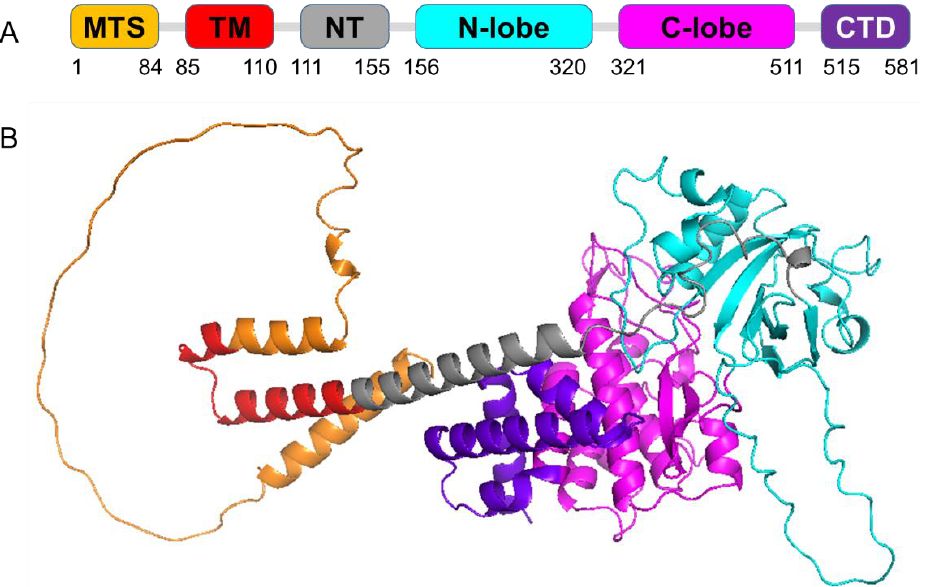
Figure 2. Three-dimensional (3D) predicted model of full-length human Pink1 (581 amino acid residues) (AlphaFold predicted model: Q9BXM7). Pink1 domain structure ( A ) and cartoon representation ( B ) are shown in colors that correspond to the respective domain colors. The domains are colored as follows: mitochondrial targeting sequence (MTS, orange), transmembrane region (TM, red), N-terminal regulatory region (NT, gray), N-lobe of the kinase domain (cyan), C-lobe of the kinase domain (magenta) and the C-terminal domain (CTD, purple). PyMol (Schrodinger LLC) was used to generate the figure [24].